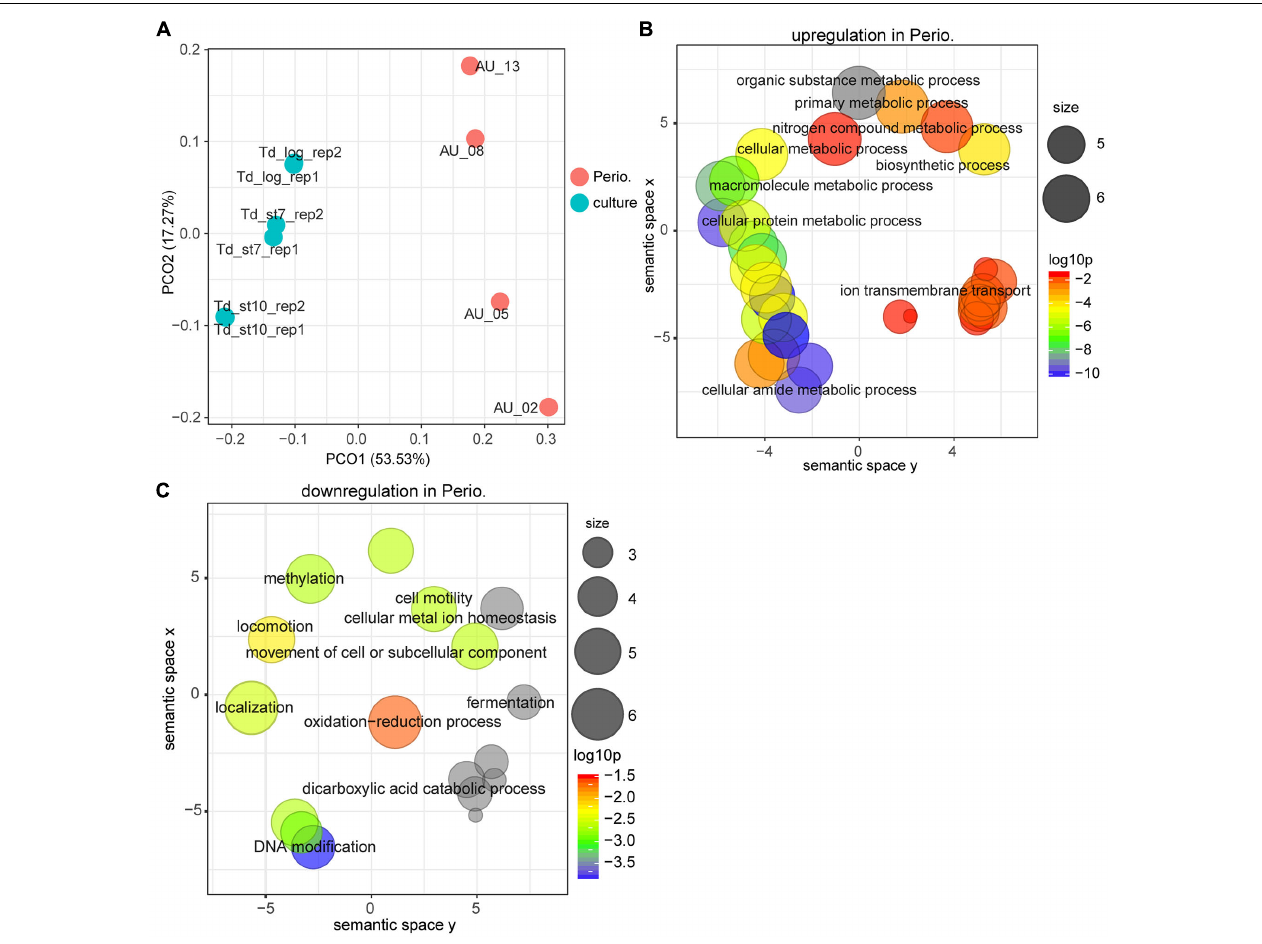
FIGURE 2 | Comparison of the transcriptional profiles between periodontitis and laboratory culture for Treponema denticola. (A) PCoA of transcriptional profiles from four periodontal pocket samples (chronic periodontitis) and laboratory cultures at log or stationary phase. (B,C) GO terms up-regulated (B) and down-regulated (C) in periodontitis. All GO terms with enrichment P -value ≤ 0.05 were summarized and visualized by REVIGO, and the size of the bubble indicates the number of merged terms.